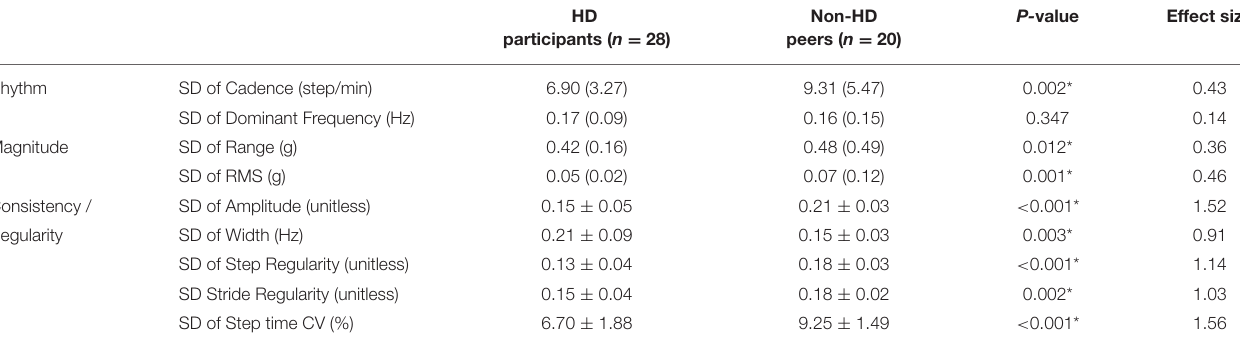
TABLE 3 | Bout-to-bout changes in daily-living gait quality in HD participants and non-HD